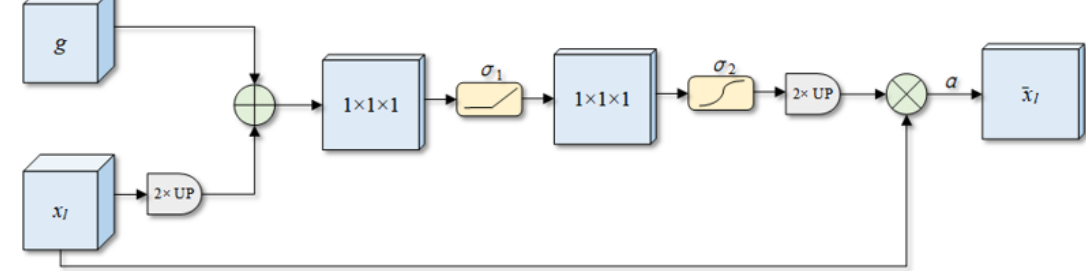
Figure 3. Schematic of additive attention gate (AG).